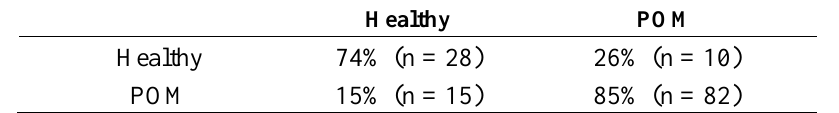
Table 3. Confusion matrix of the object based classification of the presence and absence